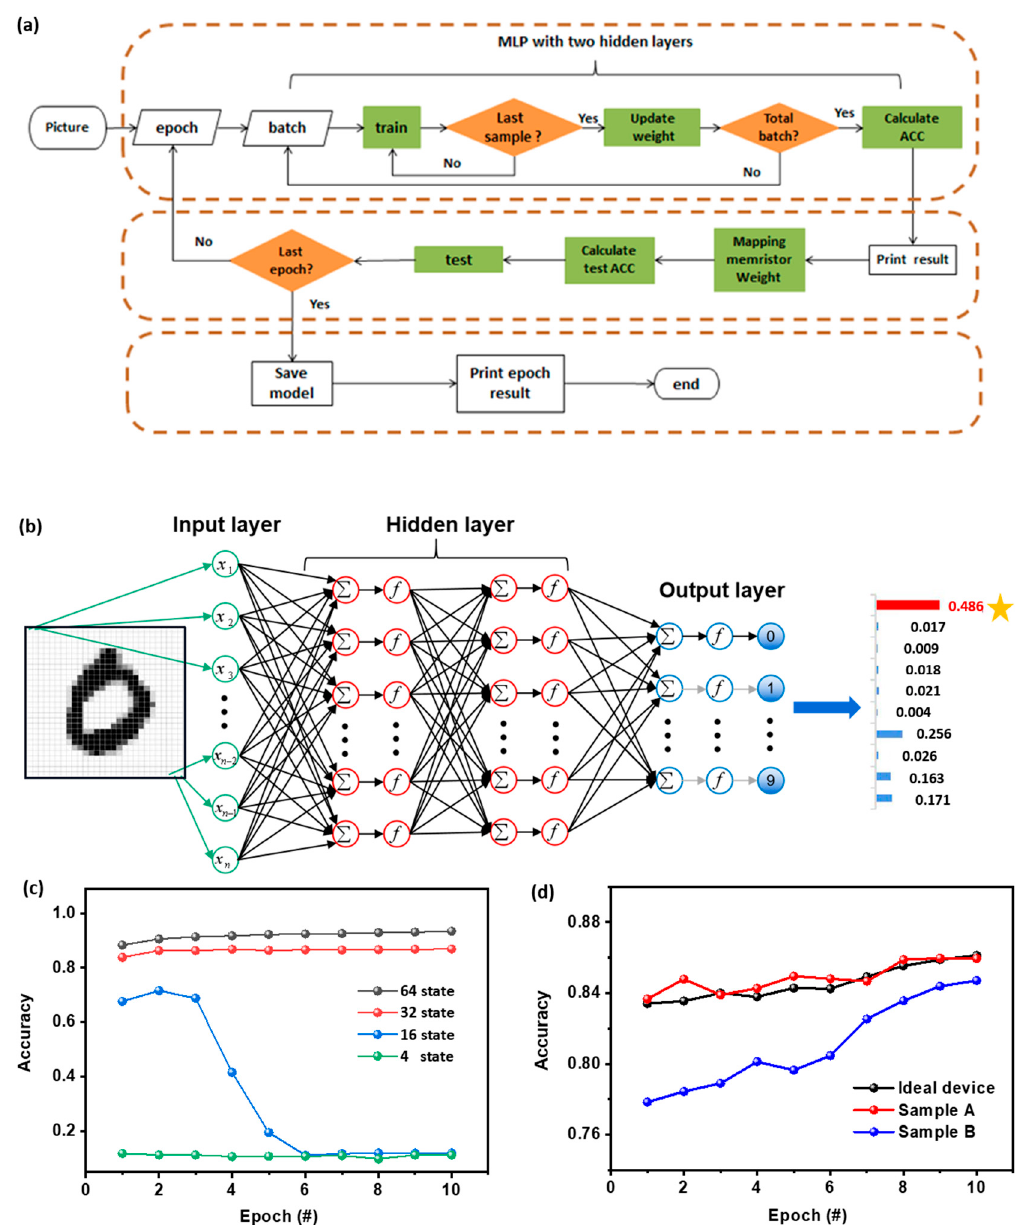
Figure 5. ( a ) Schematic flowchart for the simulation of supervised learning with multilayer perception (MLP) neural network for handwritten digit recognition. ( b ) Architecture of the MLP network. Plots of the recognition accuracy as a function of the increasing training epochs ( c ) with the available QC states numbers of 4, 16, 32 and 64 in sample A and ( d ) with 32 QC states in sample A, B, and ideal devices without conductance fluctuation.